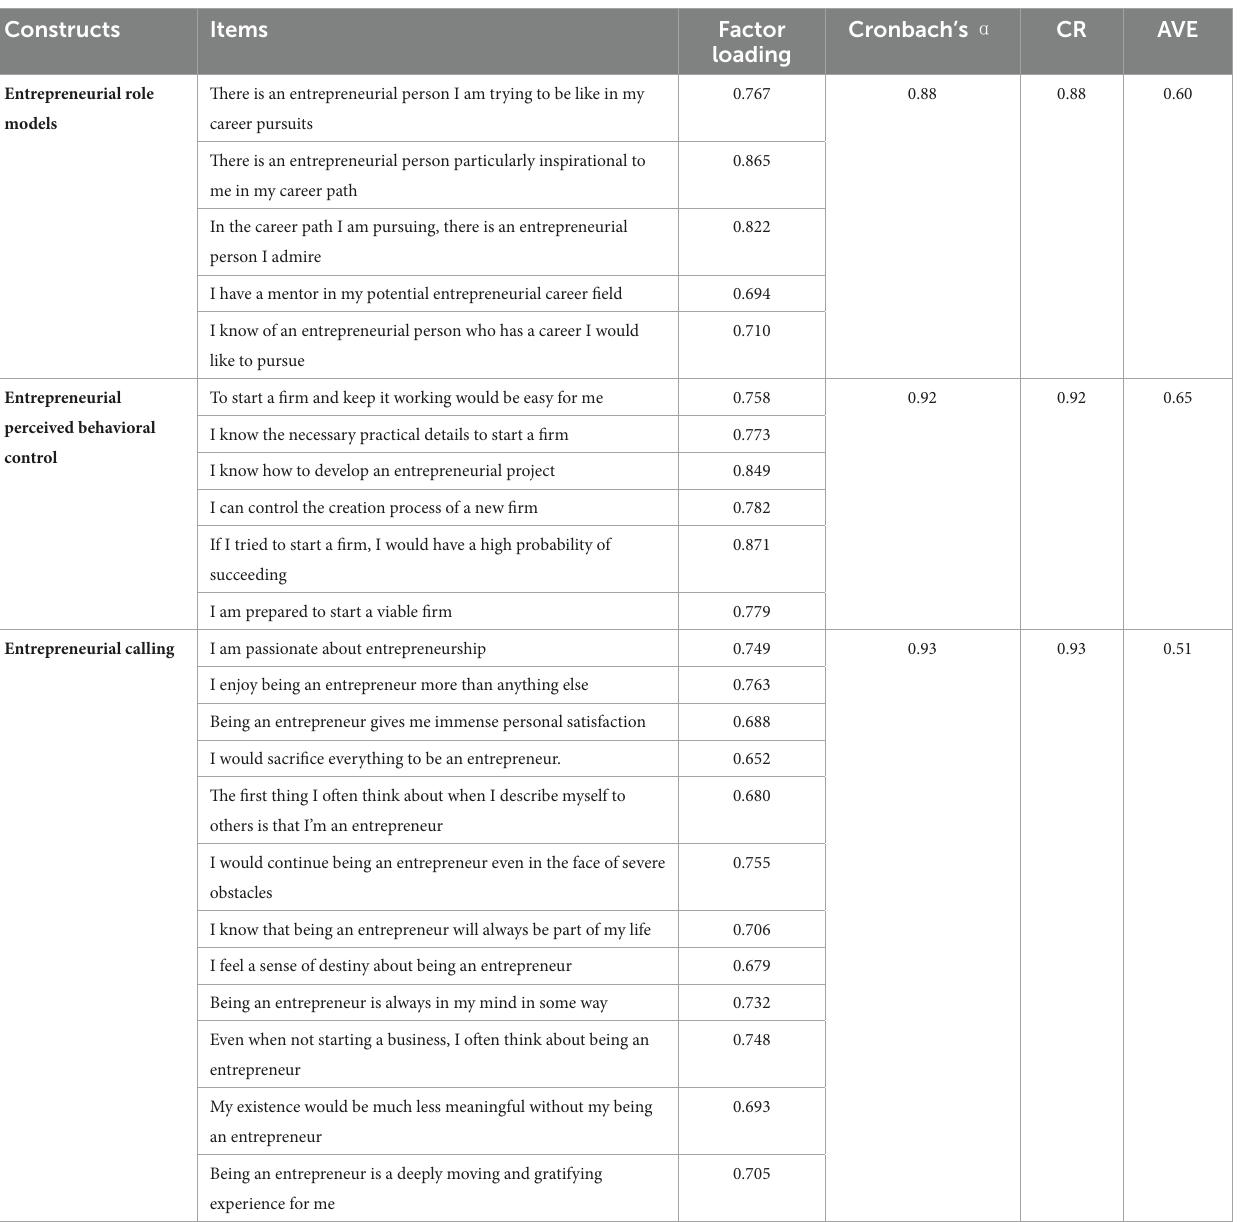
TABLE 3 Reliability and validity